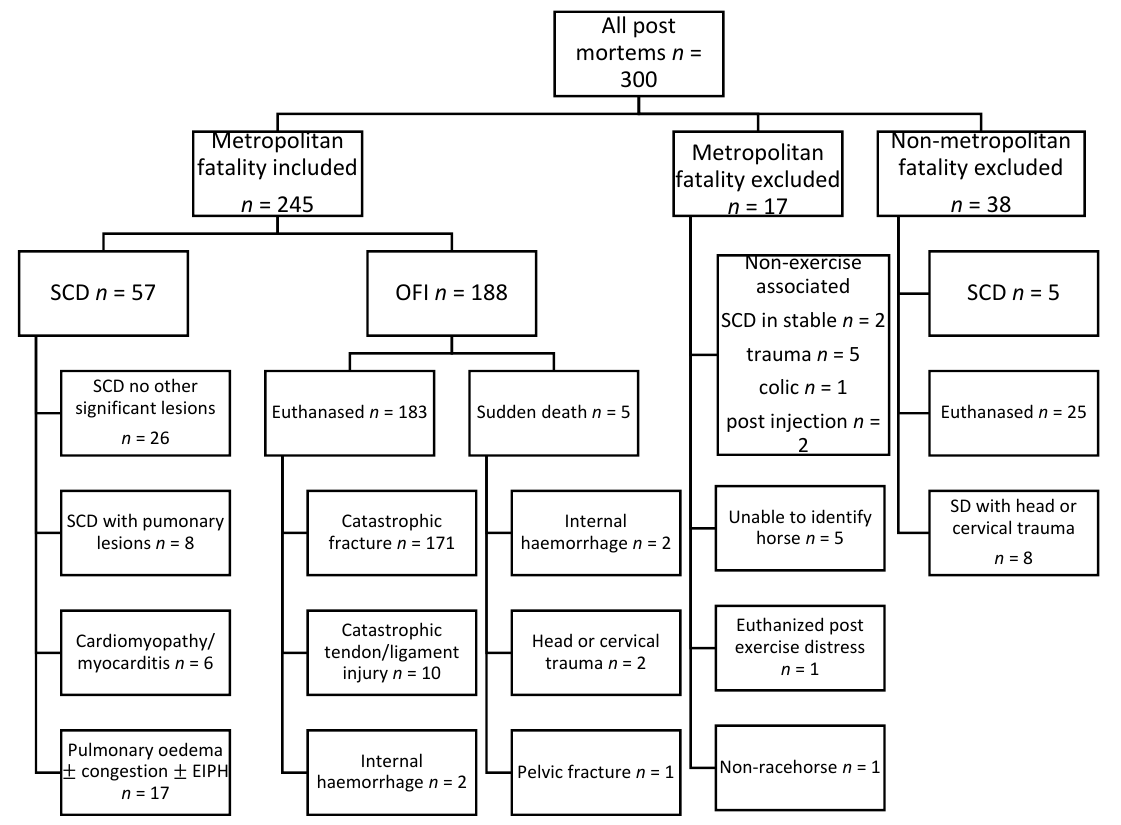
Figure 1. Flow chart summarising case selection from 300 post-mortems performed between 2007 and 2021. Non-exercise associated and non-metropolitan fatalities and non-racehorses were ex- cluded, as were cases in which the identity of the horse could not be confirmed and a single case which was euthanized for post exercise distress. Sudden cardiac deaths comprised all sudden deaths in which no significant lesions were found and sudden deaths in which a diagnosis of cardi- omyopathy/myocarditis was reached. Also included in the SCD group were cases with pulmonary lesions in which SCD could not reasonably be excluded. Other fatal injury (OFI) comprised all other fatalities during the study period. 3.2. Post-Mortem Classification A flow chart summarising classification of cases is presented in Figure 1. Post-mor- tems were performed at a single institution by one of 19 qualified veterinary pathologists. The horses were classified according to the cause of death attributed by the attending pathologist. The diagnoses provided by the attending pathologists in the 57 horses with a final classification of SCD were as follows: 26 horses had a diagnosis of SCD without any other significant lesions, three horses had SCD and exercise-induced pulmonary haemor- rhage (EIPH), two horses had SCD and pulmonary oedema and congestion, two horses had SCD and pulmonary oedema and one horse had SCD with EIPH, pulmonary oedema and congestion. Of the six horses with myocardial lesions, three horses had a final diag- nosis of cardiomyopathy, two horses had myocarditis and one horse had left ventricular concentric hypertrophy. Of the remaining 17 horses in which SCD could not reasonably be excluded, 11 horses had severe EIPH, two horses had mild EIPH, three horses had EIPH and pulmonary oedema and congestion, and one horse had pulmonary oedema alone. The 188 horses classified with OFI included 183 horses that were subject to euthana- sia and five horses with SAD. Of the horses that were euthanized, there were 106 horses that had a distal limb fracture, 59 horses with a proximal limb fracture and six horses with fracture associated with cervical or thoracic trauma. In addition, there were ten horses with a tendon or ligament injury and two horses with internal haemorrhage, which were